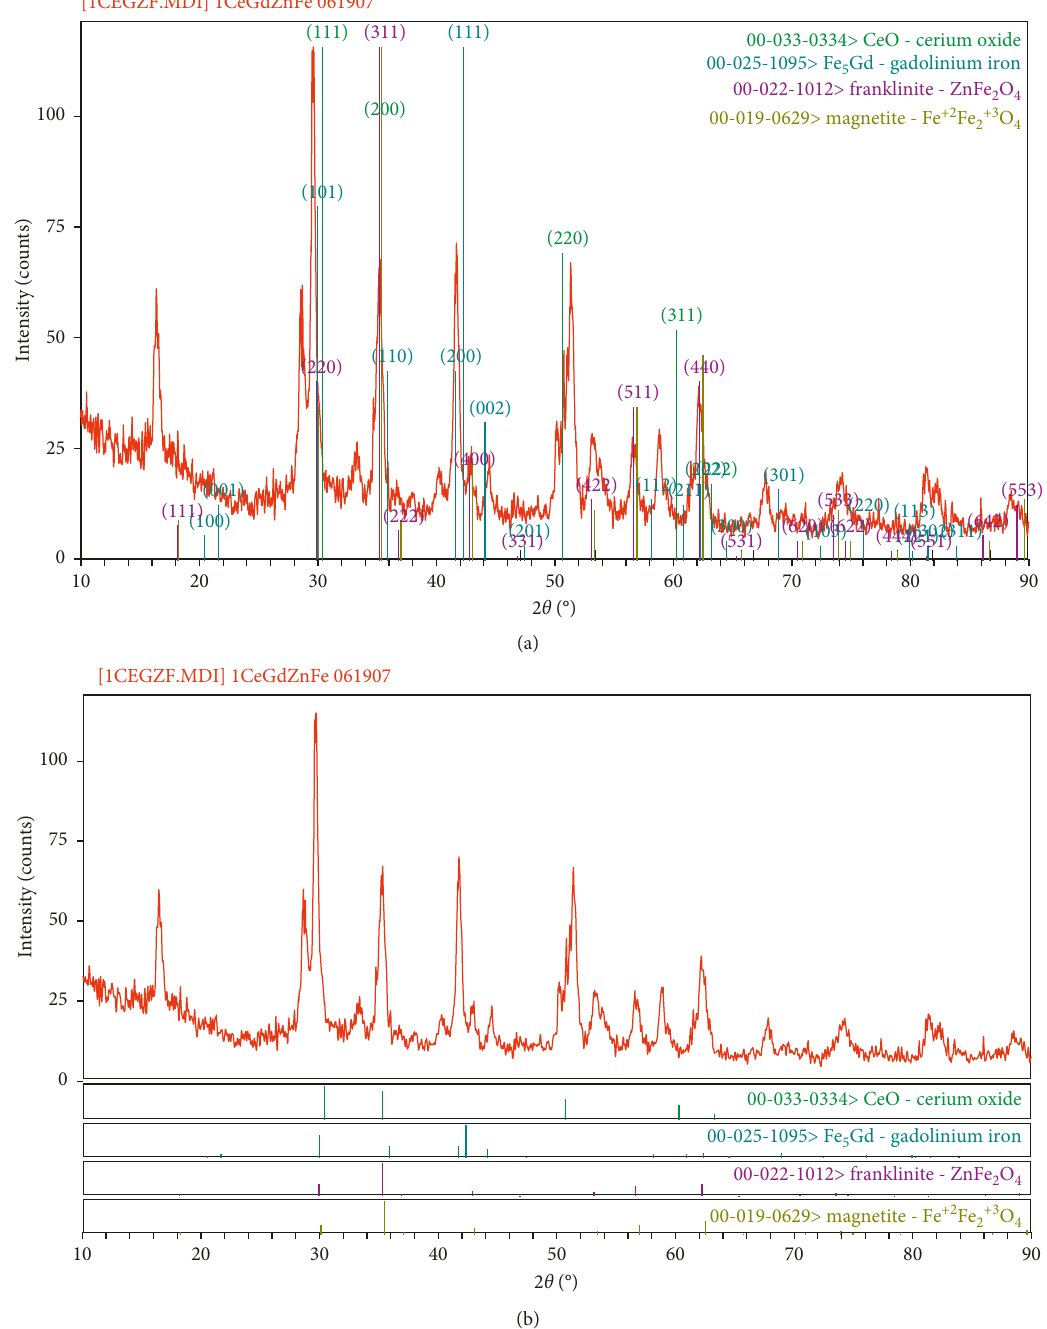
Figure 2: Powder X-ray diffraction pattern of and reference pattern for CeGdZn-ferrite magnetic nanoparticles. The pattern is repre- sentative for all the samples of the